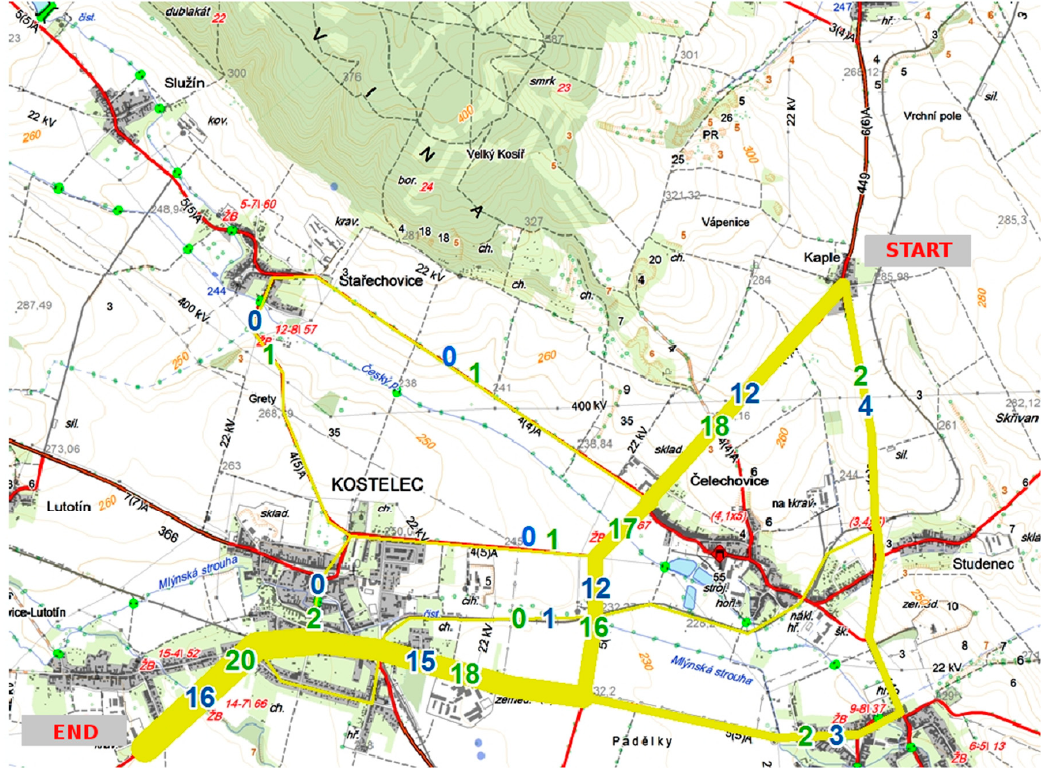
Figure 13. Yellow lines ( thickness ) express frequency of the routes chosen by the experimental group ( green digits ) and control group ( blue digits ) together. Data from both groups are presented at once in the transport map.